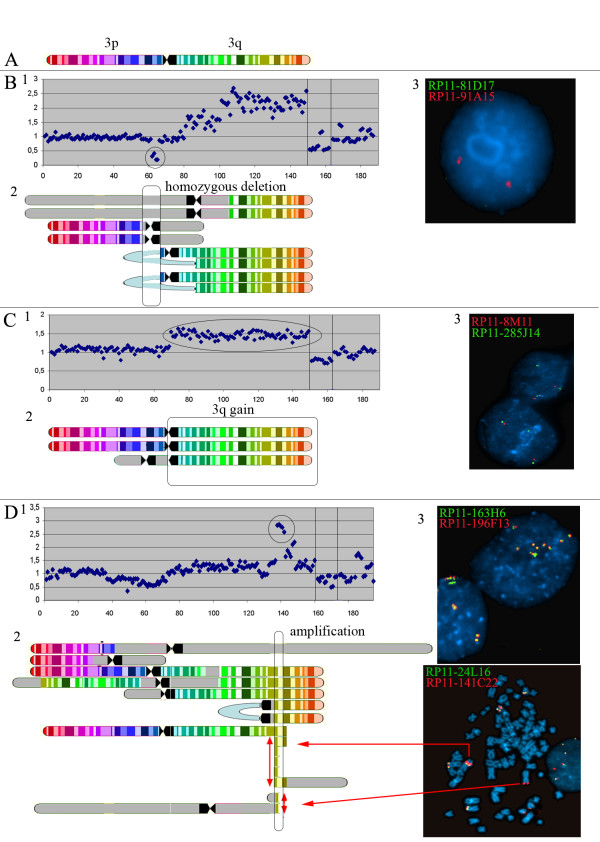
Array-CGH profiles and mpFISH of three cancer cell lines displaying different chr3 aberrations. A. Colour coding of banding pattern on the chr3 ideogram. B. Detection of homozygous deletion at 3p12-p13 in U2020. B1. Array-CGH detection of homozygous deletion (circle on the plot) (ANILFR ± 1 sd; 0.28 ± 0.1 as shown in Table 1). See for chart description legend to Fig 3. B2. Schematic representation of chr3 segments on the rearranged chromosomes according to mpFISH results. Grey parts represent translocation partners from other chromosomes. Blue loops show fusion between fragments. Rectangle box marks the chr3 region, corresponding to a homozygous deletion (0 copy number), missing in all rearranged chromosomes. Each piece from chr3 corresponds to the colour code given in A. B3. Interphase mpFISH visualizing the homozygous deletion. Probes RP11-91A15 (red) and RP11-81D17 (green) represent the region 3p11 outside and 3p12.2 within homozygous deletion, respectively. C. Terminal 3q gain in UOK125 using array-CGH (ANILFR ± 1 sd; 1.46 ± 0.08) (C1), metaphase mpFISH (C2) and interphase mpFISH (C3) (3 copies of 3q). The general layout follows the structure described for Fig 5B highlighting 3q gain of 3 copy number. On C3 RP11-8M11 (2 red signals on each nucleus) and RP11-285J14 (3 green signals on each nucleus) are located at 3p12.1 and 3q11.2 respectively. D. Amplification at 3q26 in HONE1 detected by array-CGH (ANILFR ± 1 sd; 2.81 ± 0.05) (D1), metaphase mpFISH (D2) and interphase mpFISH (D3) (13 copies). The general layout follows the structure described for Fig 5B. Arrows on D2 indicate duplication cycles within the amplified region. Interphase FISH image shows higher amplification of region at 173.25 Mb (RP11-163H6; green signals) compared to region at 173.65 Mb (RP11-196F13; red) within 3q26.31. On metaphase mpFISH image red signal corresponds to RP11-141C22 at 170.36 Mb, green signal corresponds to RP11-24L16 at 169.69 Mb within 3q26.2. Red arrows show amplified loci on rearranged chromosomes corresponding to our schematic representation on D2.